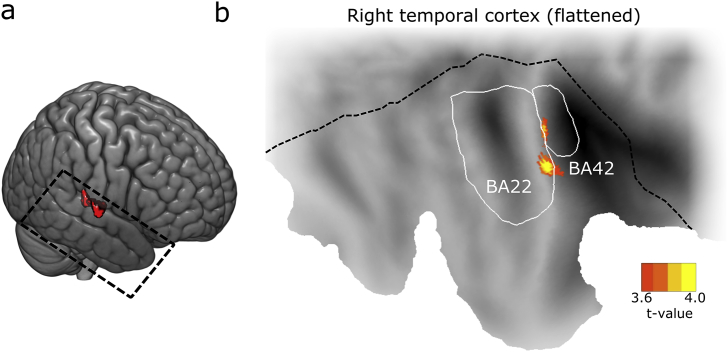
Searchlight results in entire ACX, encompassing HG, STG including temporal plane, and probabilistically defined A1. (a) Significant cluster of classification accuracy CS > NS (red). (b) View on flattened right temporal cortex. The cluster extends from Brodmann area (BA) 42 to BA 22.